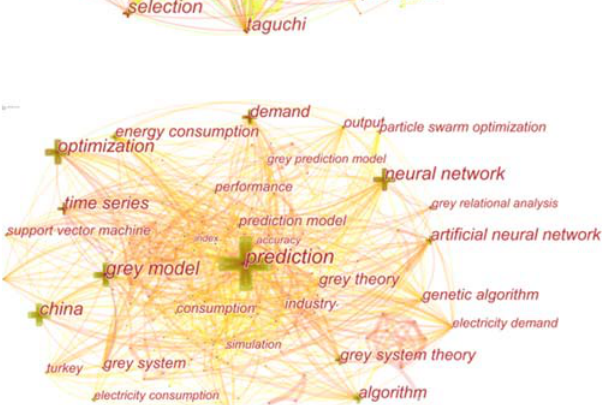
Figure 8. The keywords map of grey relational literature